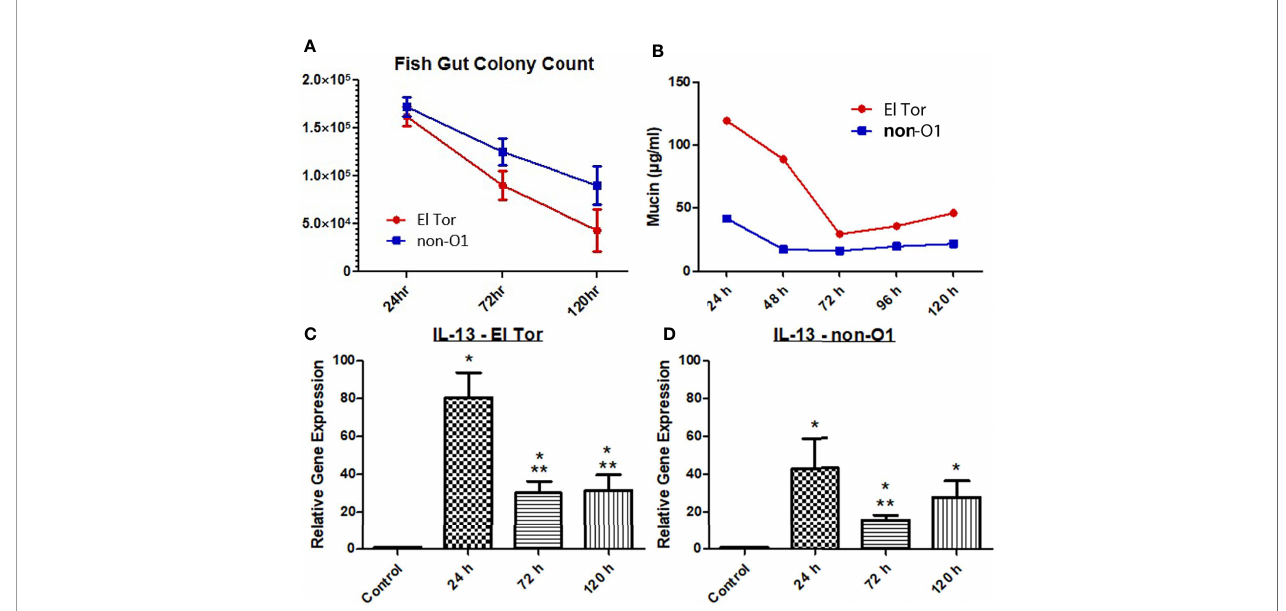
FIGURE 2 | Mucin and IL-13 levels increase during V. cholerae infection. WT zebra fi sh (n=5) were infected with E7946 (El Tor) or 25493 (non-O1) strains of V. cholerae at 2.5 x 10 7 CFU/mL and then sacri fi ced at the indicated time points, or water was taken during indicated time points. (A) CFU of the indicated V. cholerae strain taken from zebra fi sh intestines. (B) Mucin levels in the water of zebra fi sh infected with the indicated V. cholerae strain. (C) IL_13 expression in fi sh infected with El Tor strain E7946. (D) IL-13 levels in fi sh infected with non-O1 strain 25493. Mucin levels were determined via microtiter PAS assay. mRNA levels were determined through qRT- PCR. Gene expression was normalized against b -actin and expressed as fold change. Error bars indicate standard deviation. Data shown is from three experiments. *P < 0.05 as compared to control, **P < 0.05 as compared to 24 h